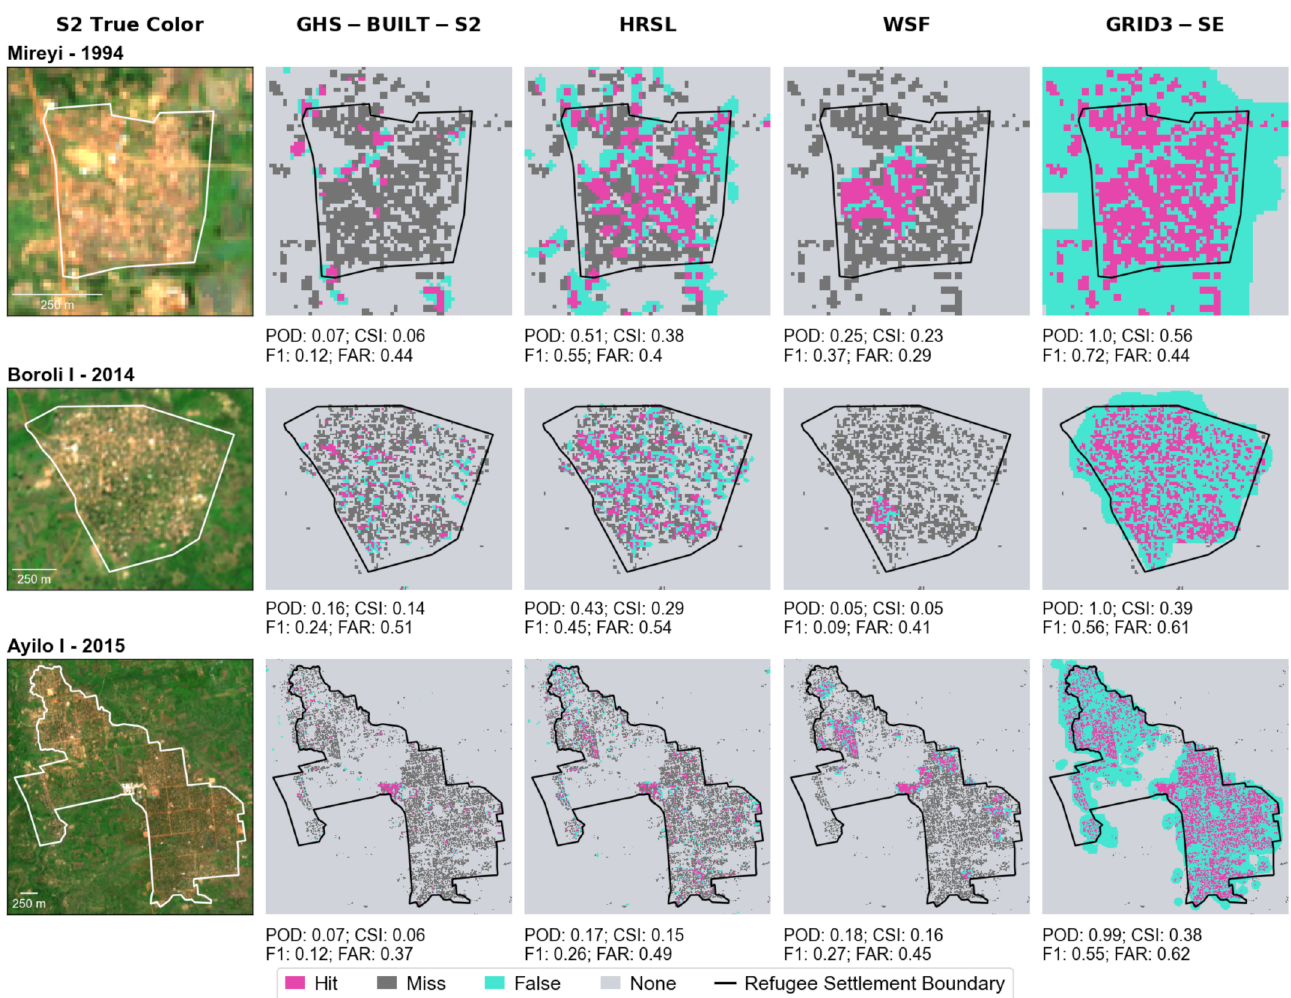
Figure 10. Settlement-level maps and detection metrics for the four settlement products at Mireyi, Boroli I and Ayilo I. De- tection metrics were evaluated relative to OSM–MS building footprint coverage within settlement boundaries. Background images based on Sentinel-2 (S2) true-color imagery from August 2019. GHS-BUILT-S2, Global Human Settlement Layer with Sentinel 2; HRSL, High Resolution Settlement Layer; WSF, World Settlement Footprint; GRID3-SE, Geo-Referenced Infrastructure and Demographic Data for Development settlement extent data; POD, probability of detection; CSI, critical success index; F1, F1-score; FAR, false alarm